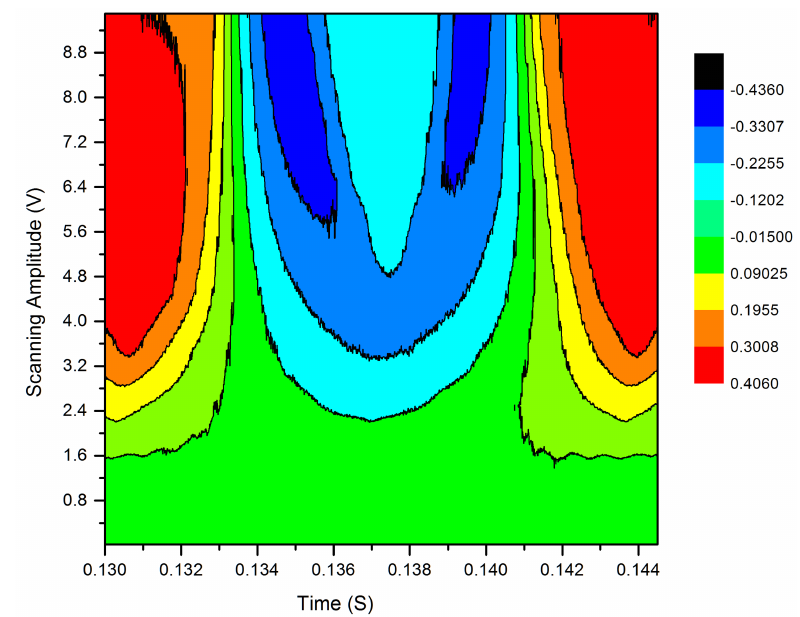
Figure 3. Intensity fluctuation as a result of applied periodical triangular waveform to the AOM driver. The initial green region indicates no or non-detectable fluctuation in intensity for scanning amplitude up to 1.6 V. This corresponds to intensity stability for modulation up to 30 MHz in the double pass setup. When scanning amplitude (i.e., the amplitude of the triangular waveform) is increased to above 1.6 V, small variation in intensity can be detected. Above 2.4 V, a clear fluctuation in intensity can be seen in the form of the color of the contour. The time axis has units of (S) however, this has no significance because it corresponds to the time directly taken from the oscilloscope.